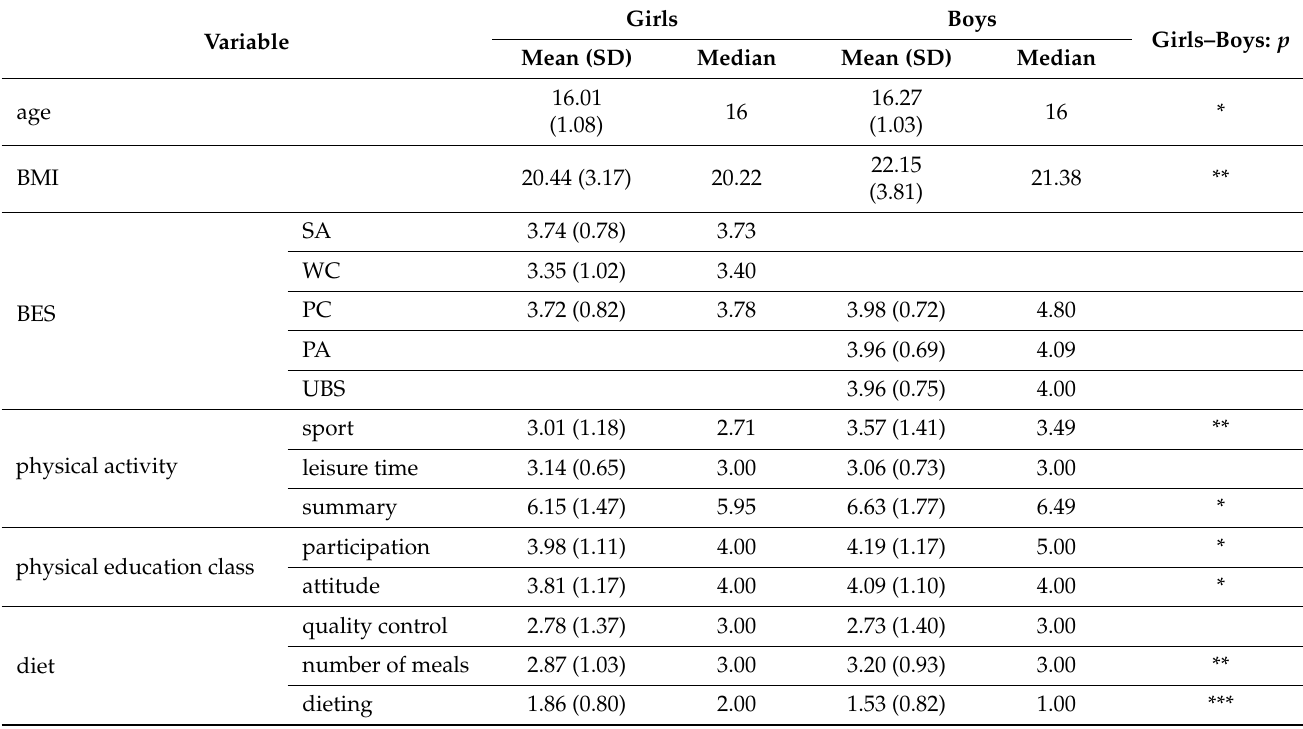
Table 1. Descriptive statistics of the analyzed variables and comparison by